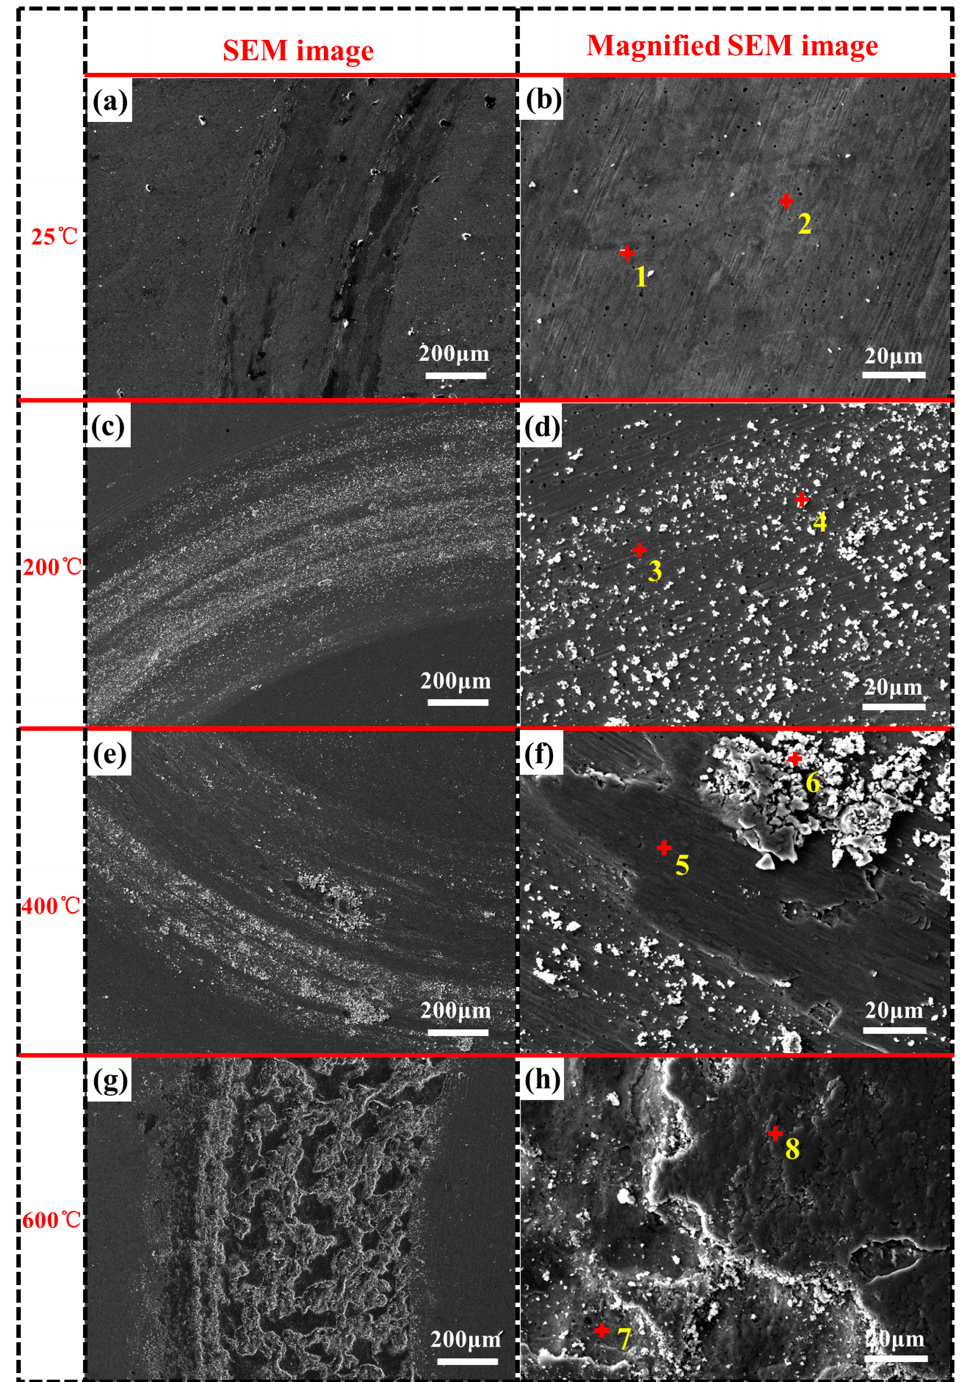
Figure 6. AZ wear morphology at different temperatures: ( a , b ) 25°C, ( c , d ) 200°C, ( e , f ) 400°C, ( g , h ) 600°C.